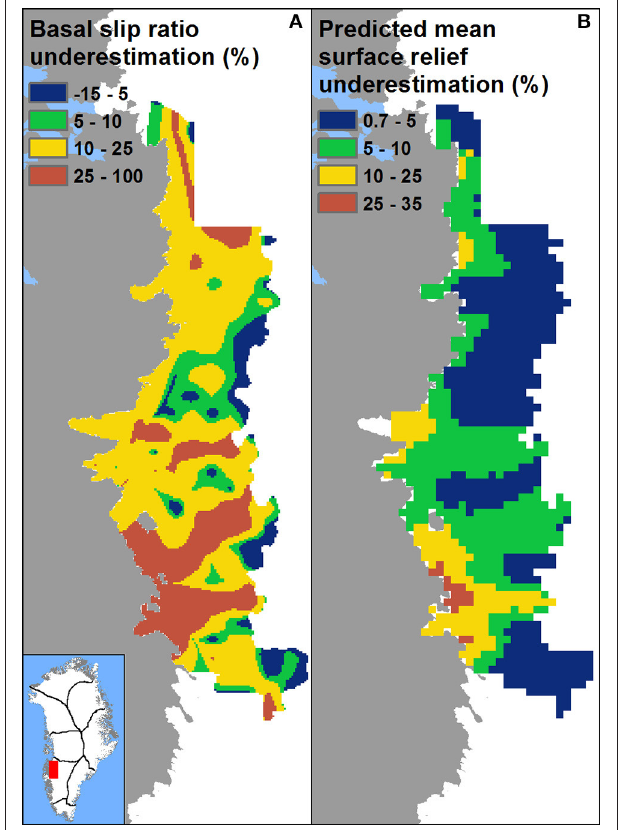
FIGURE 7 | (A) The percentage of the basal slip ratio underestimation caused by the usage of winter, instead of annual, ice flow velocities, (B) the underestimation of the predicted mean surface relief caused by the usage of winter, instead of annual, basal slip